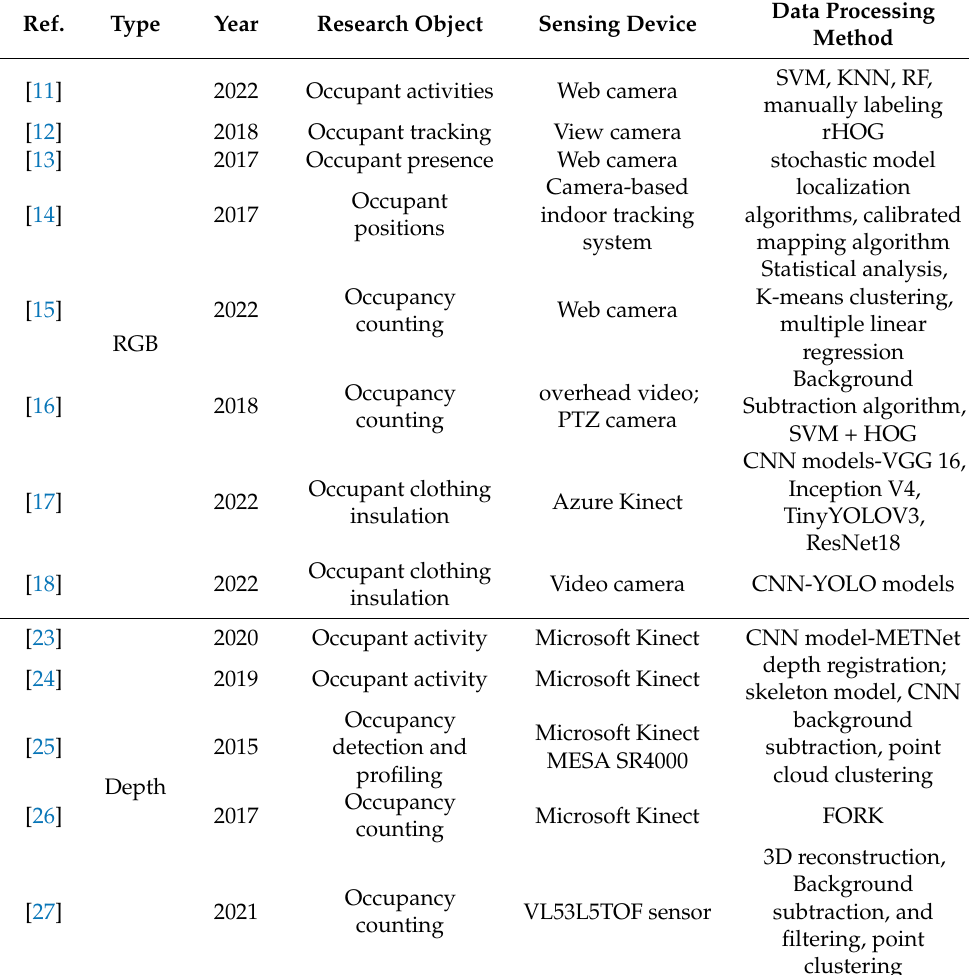
Table 1. The list of references for image-based sensing technologies.